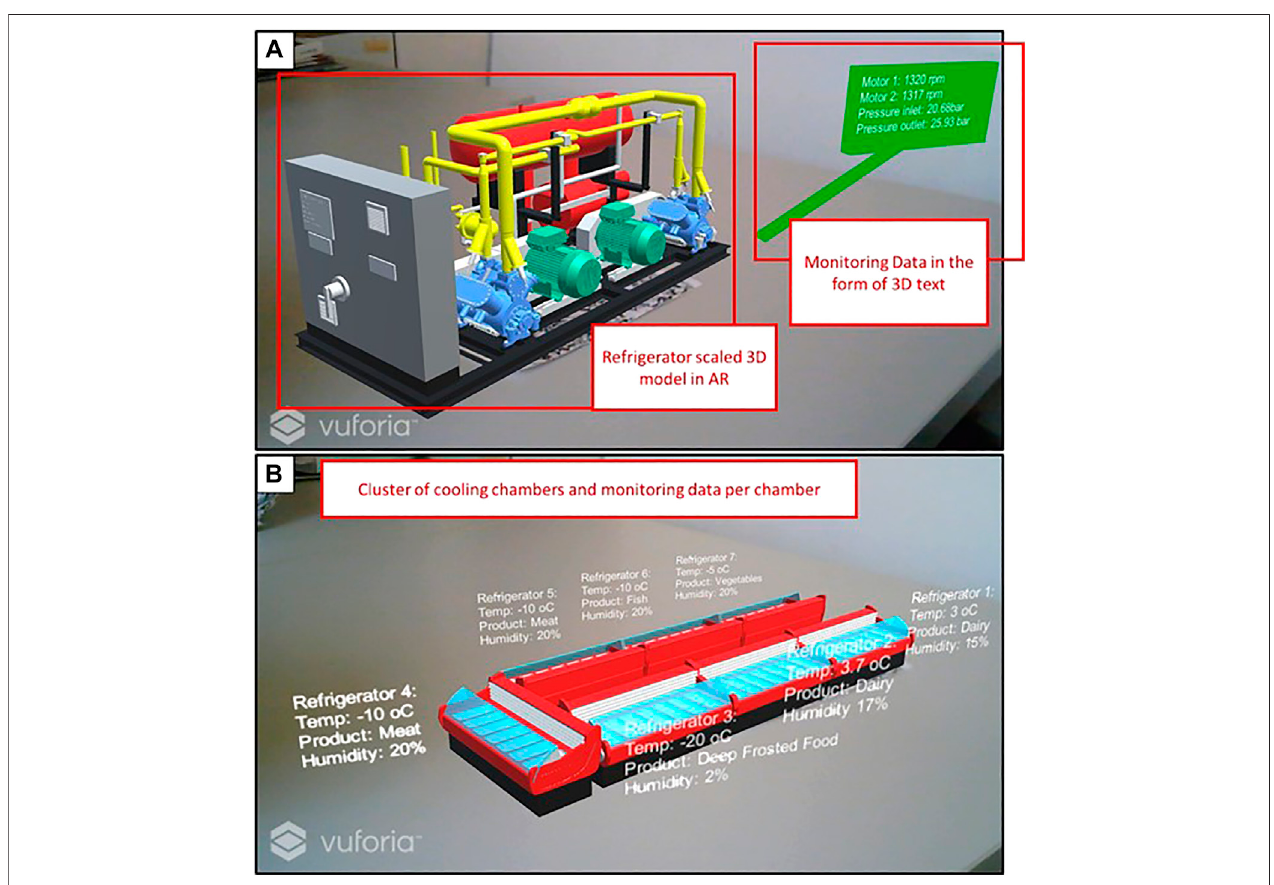
FIGURE 6 | (A) AR visualization of compressor and its working parameters; (B) Cooling chamber cluster and the current working